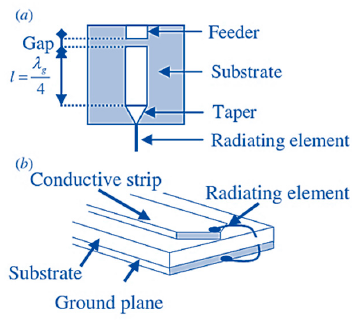
Figure 2. Microstrip resonator design: ( a ) complete structure; and ( b ) zoomed in on electric dipole (from [29]; copyright © 2008; redesigned with permission).